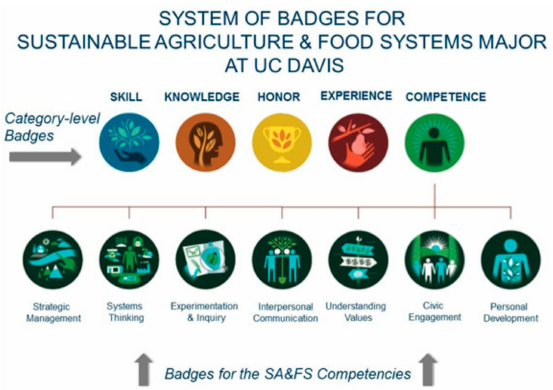
Figure 3. Digital badge system for sustainable agriculture & food systems major at U.C.